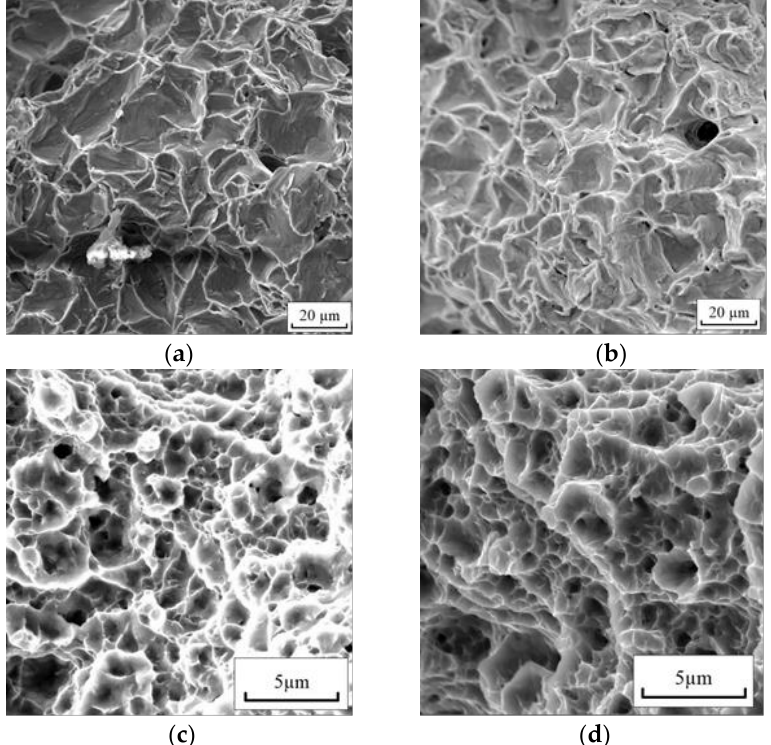
Figure 9. Fracture surface of CG ( a , b ) and UFG ( c , d ) Grade 4 under tension: ( a , c )—no current; ( b , d )—with current of j = 60 A/mm 2 τ = 100 µ